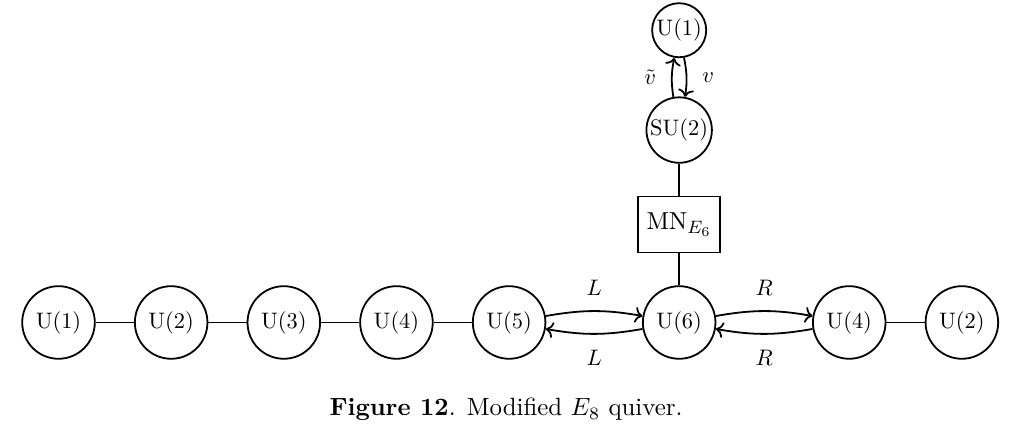
Figure 12 . Modified E 8